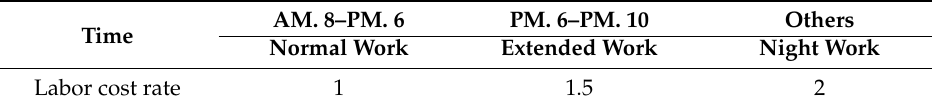
Table 2. Labor cost rate at each time